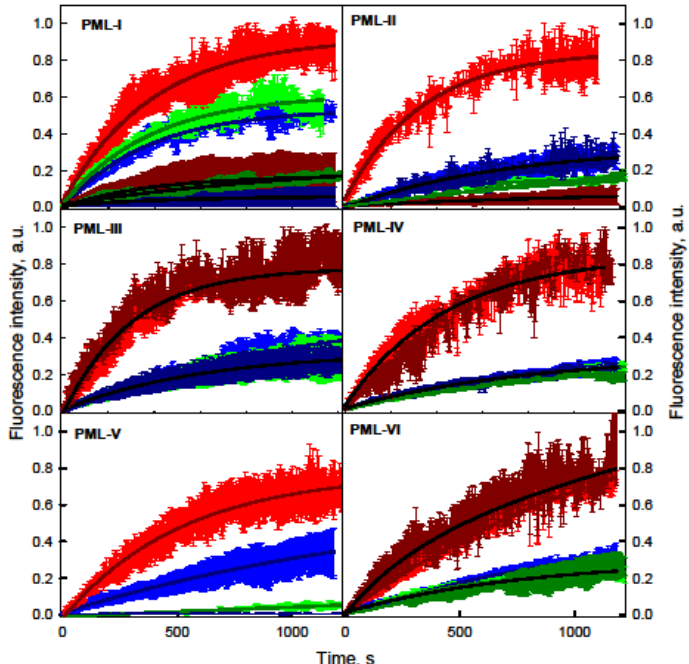
Figure 5. The acute oxidative stress action on the dynamics of exchange of PML isoforms with nucleoplasm in U2OS cells. The red, blue, and green curves are similar to those in Figure 4. Dark red indicates the curves of photoreduction of PML isoforms in the composition of “ small ” PML- bodies in the presence of 500 μM H 2 O 2 , dark blue indicates the curves of photoreduction of PML isoforms in the composition of “ large ” PML bodies in the presence of 500 μM H 2 O 2 , dark green — curves of photoreduction of PML isoforms in APBs in the presence of 500 μM H 2 O 2 . Solid curves represent the approximation of FRAP data in the framework of the mono-exponential approximation. The standard deviation of the data is passed by error bars of the corresponding color.